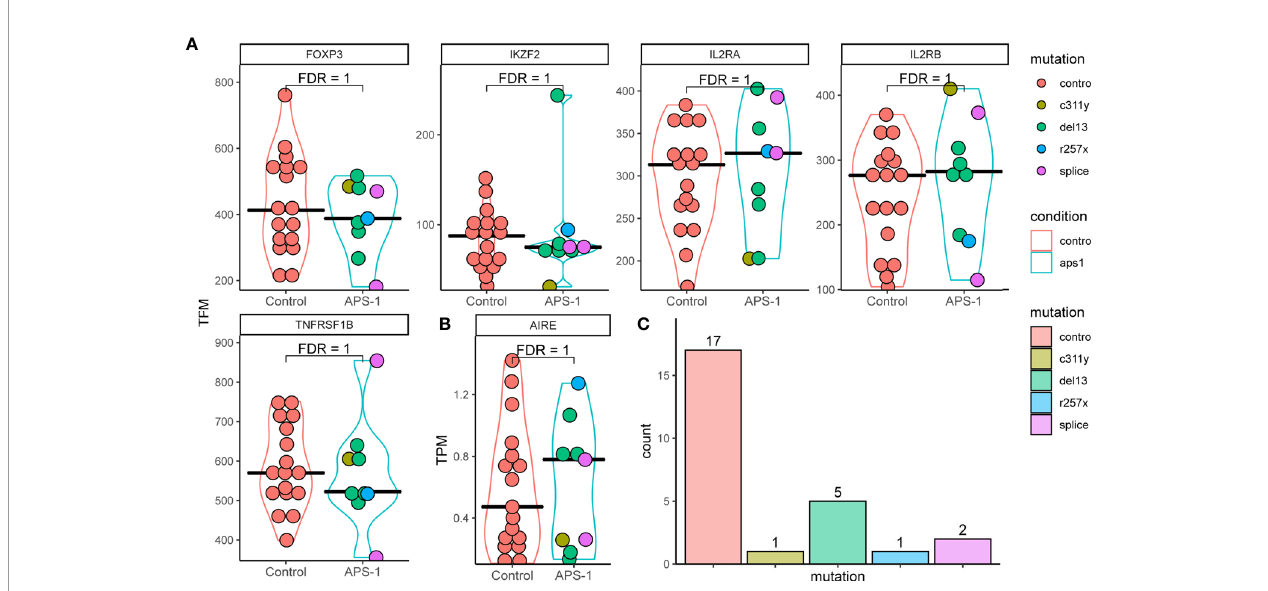
FIGURE 2 | Violin plots of RNA expression levels in transcripts per million (TPM) of important regulatory T cell markers in Tregs of APS-1 patients (cyan) and healthy subjects (red). (A) APS-1 mutations are indicated by the color of the dots within the violin plot. AIRE expression in TPM for the different groups shown in (B) Histogram of distribution of patients and controls according to genotype in (C) FDR values taken from differential expression analysis using DESeq2 in